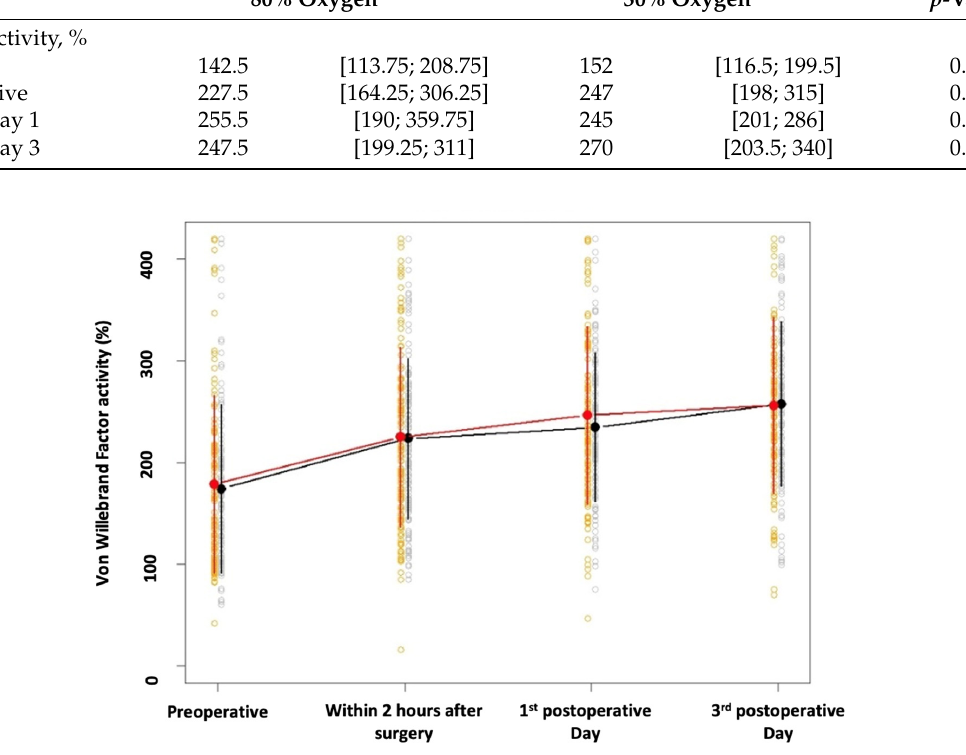
Figure 1. Time course for von Willebrand Factor activity. Mean values (dots) and standard deviations (vertical lines) for vWF separately for time and the 30%-group (black) as well as the 80%-group (red). The blank dots give the values of the observed individuals, separately for the two groups.